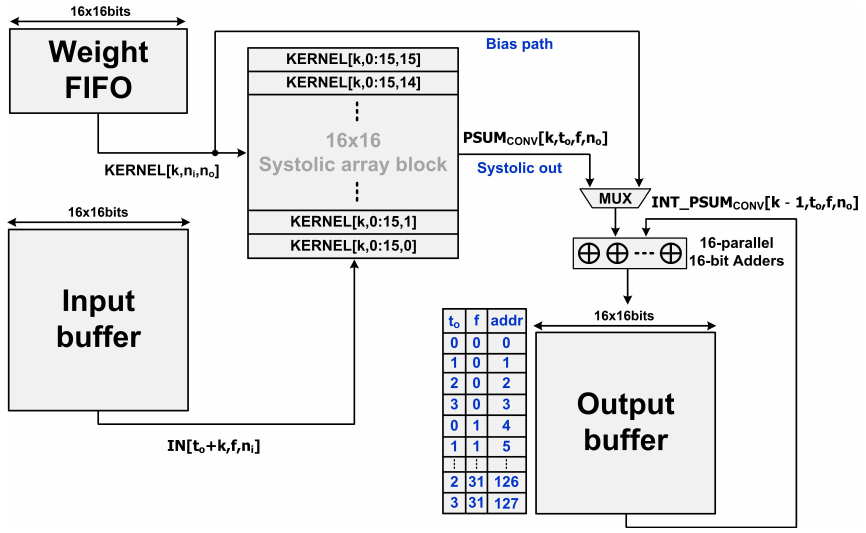
Figure 6. Hardware operation of CONV2D example in Table 6. Table 7. Clock cycles for each pipeline stage in an example CONV2D operation of Figure